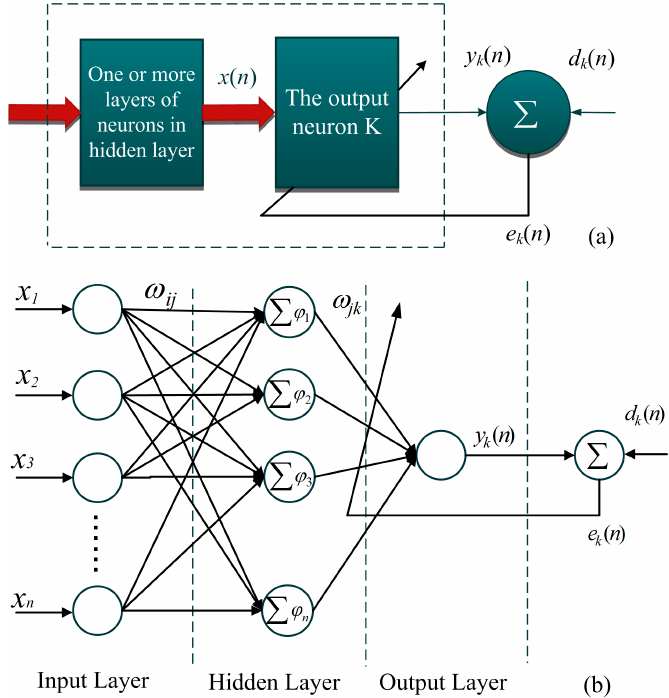
Figure 3. Schematic diagram of the error correction learning algorithm: ( a ) the neural network block, ( b ) the neurons’